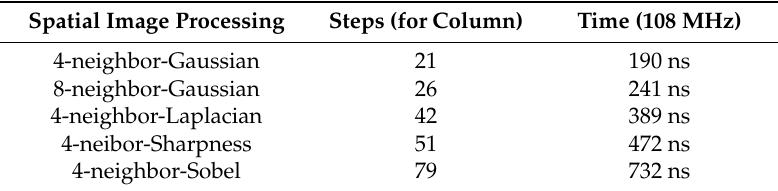
Table 5. Steps of sample